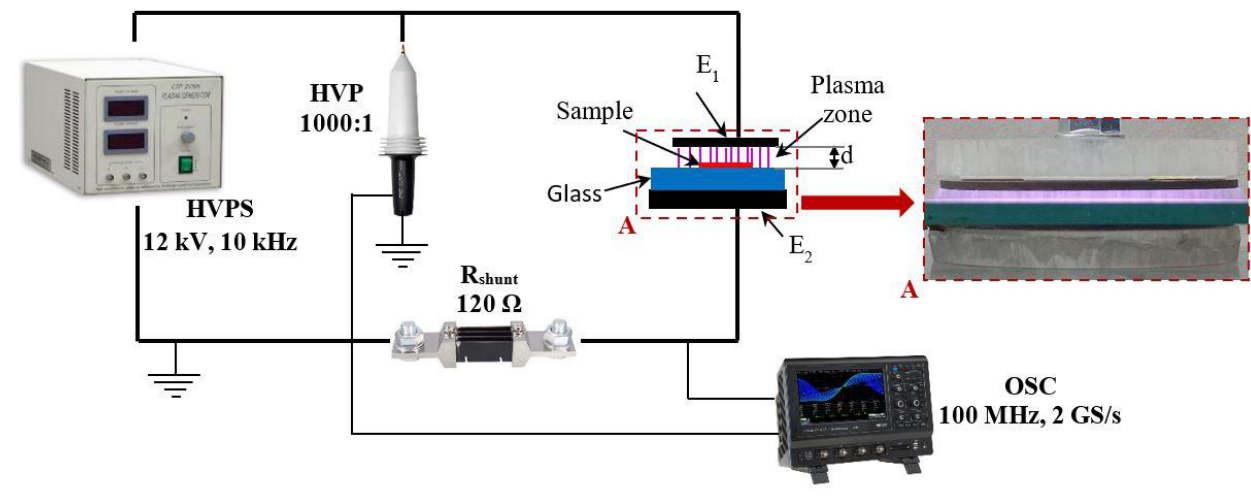
Figure 2. Schematic diagram of experimental set-up.